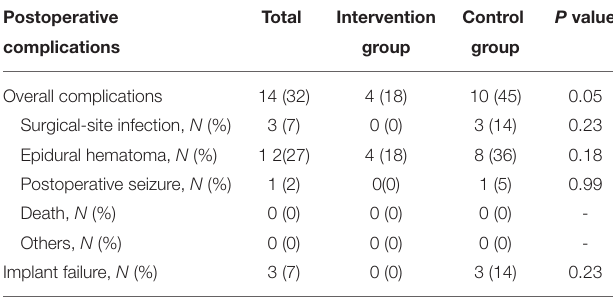
TABLE 3 | Postoperative complications of patients.